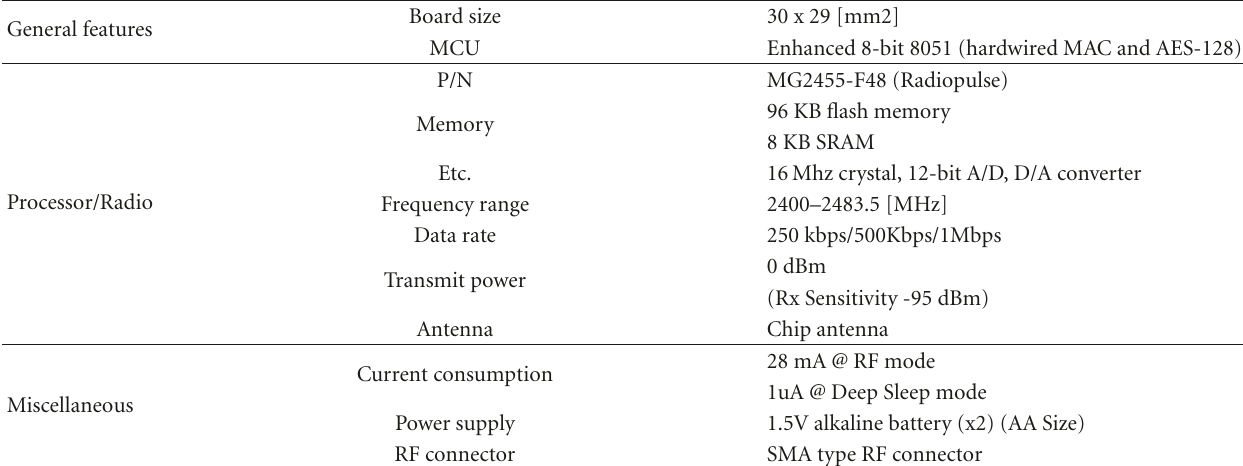
Table 1: Specification of RF4CE prototype board.